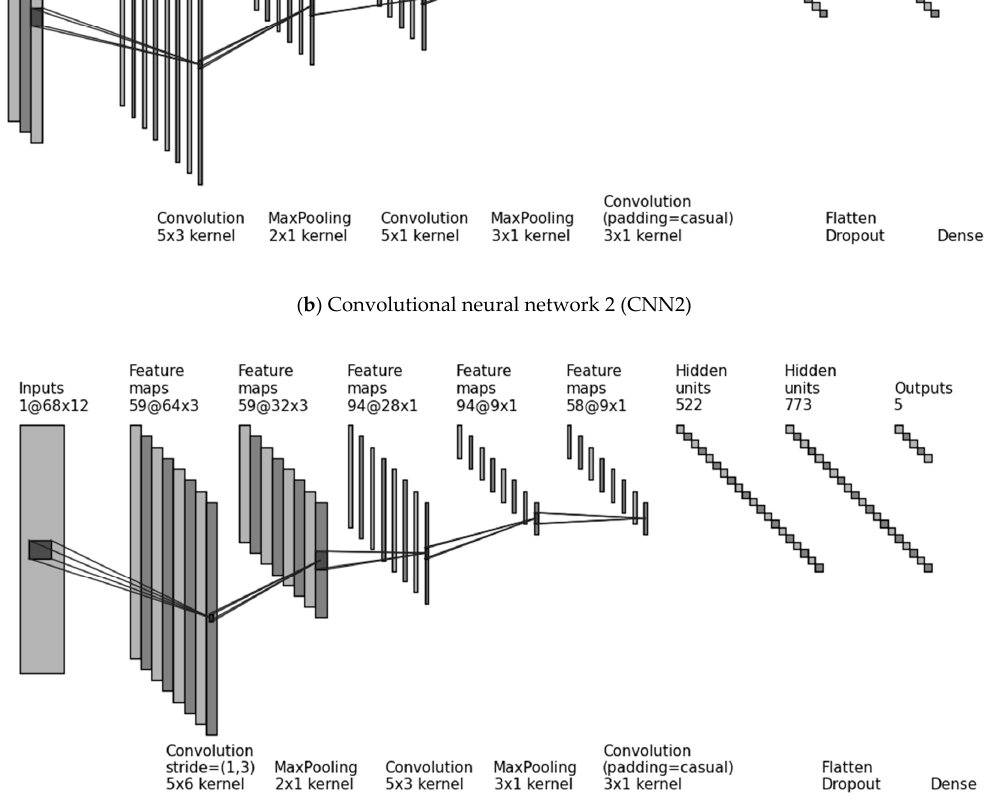
Figure 2. The 3 investigated optimized deep network architectures (CNN1, CNN2, CNN3). Each convolutional layer is followed by a normalization layer and a rectified linear unit (ReLU) activation unit, which are not illustrated in the figure due to space limitations. The numbers before the character “@” indicate the depth dimension, whereas following the character “@” the size of the feature maps ( 𝑊 (cid:3400) 𝐻 ).